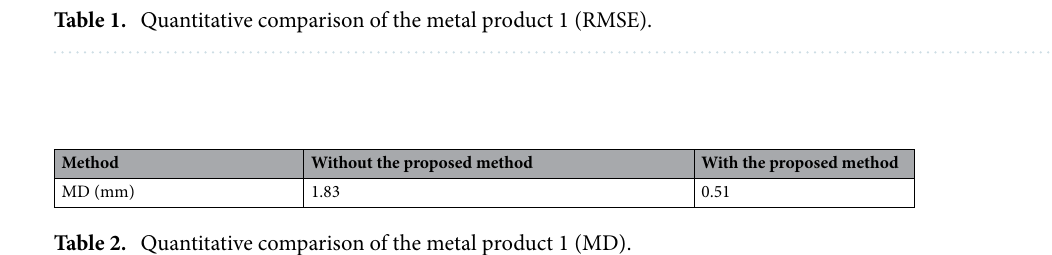
Table 2. Quantitative comparison of the metal product 1 (MD).